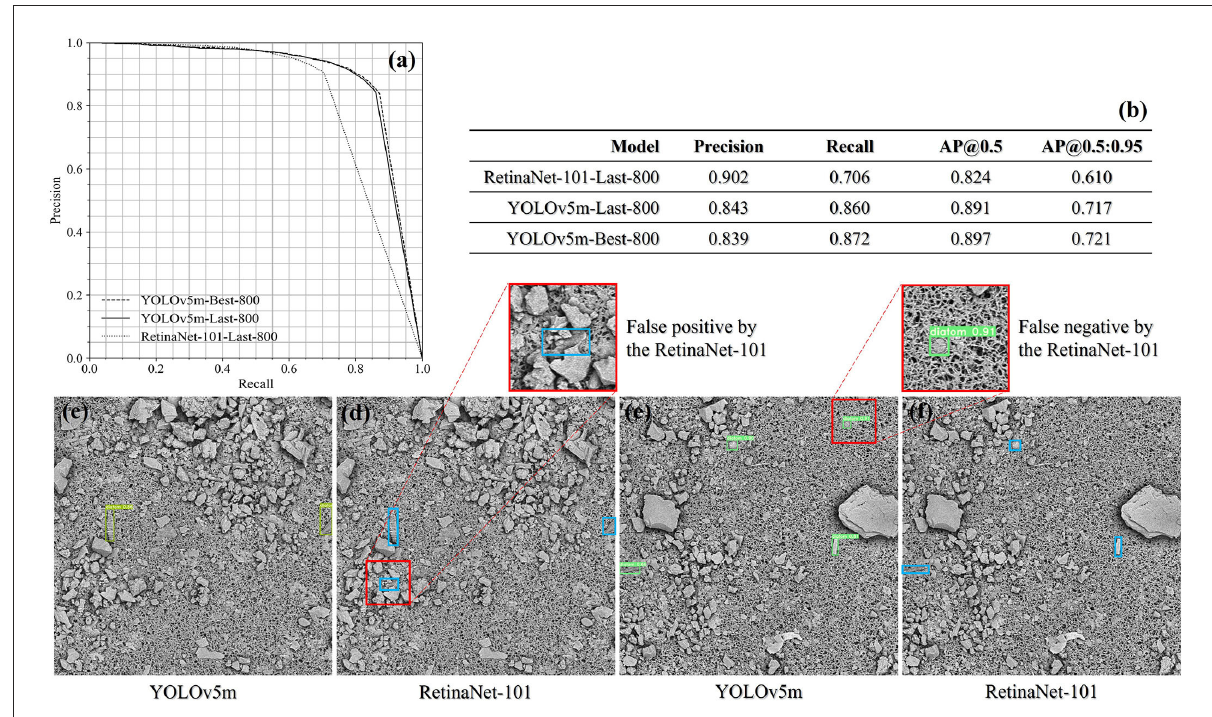
FIGURE9 The evaluation result summary of the liver and kidney samples (a,b) and two drowning cases qualitatively compared between the YOLOv5m-Last-800 model and the RetinaNet-101-Last-800 model (c–f)